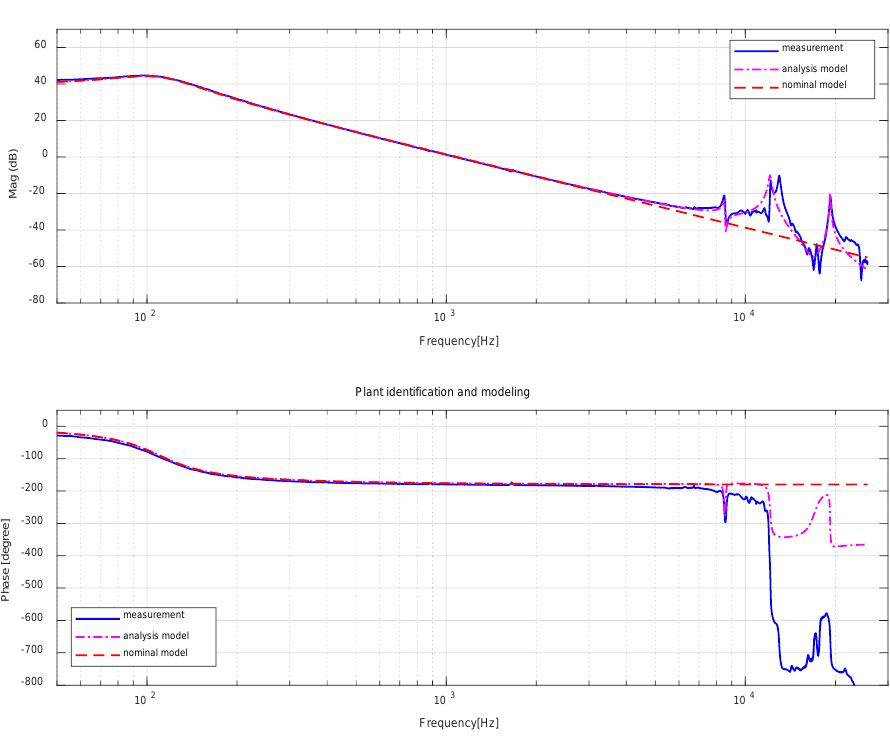
Figure 1. Plant dynamics: Measurement, model for analysis and nominal model for design.